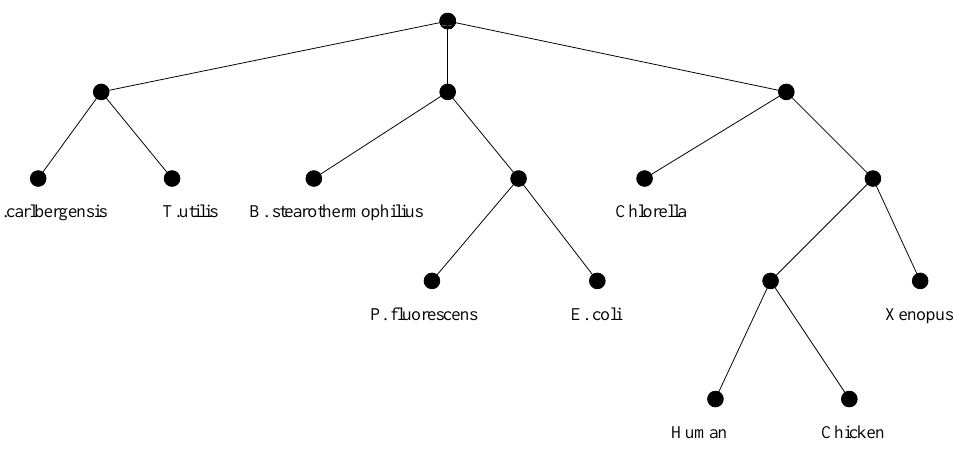
Figure 3. An example of evolutionary